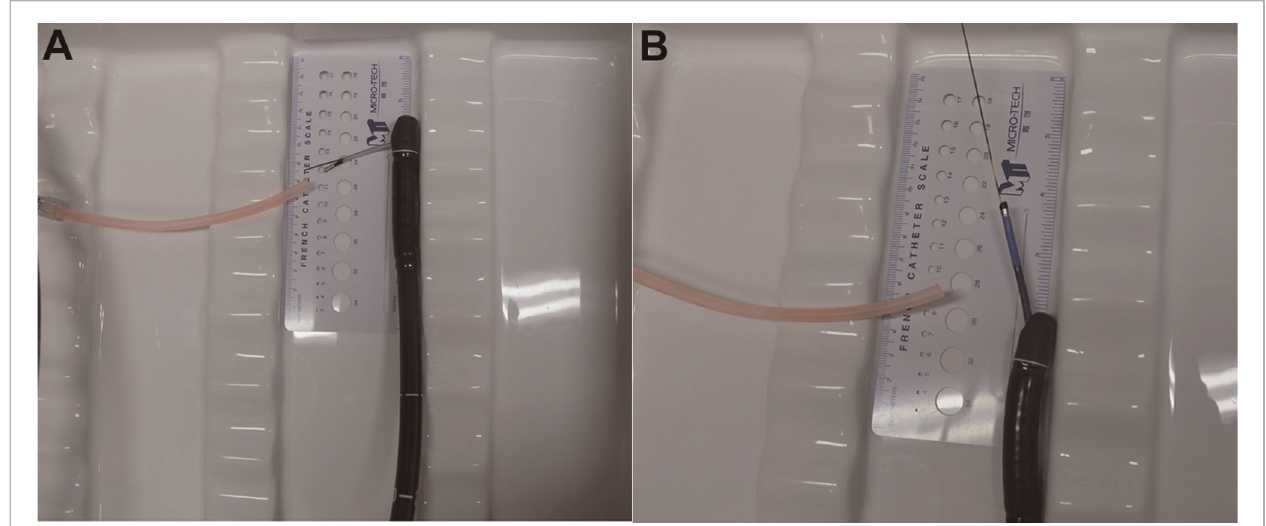
FIGURE 3 | Comparison of front-end tilting up angles. ( A ) Disposable Super fi ne Catheter for Visual Examination of Bile and Pancreatic Ducts, ( B ) SpyGlass ™